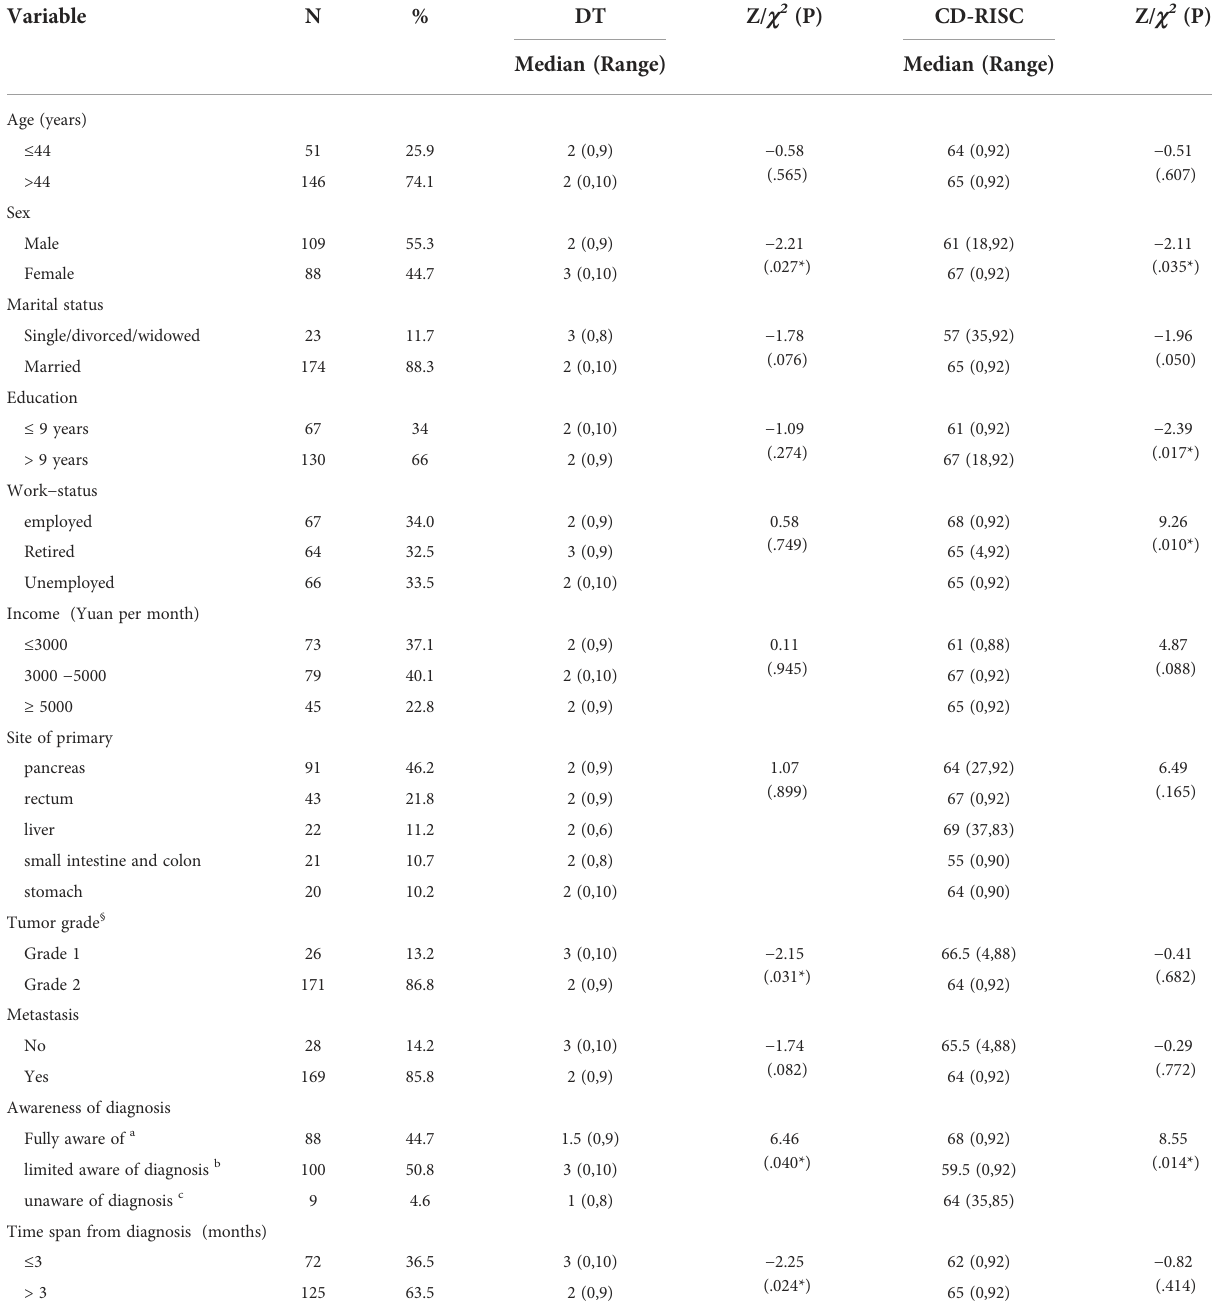
TABLE 1 Demographic and clinical characteristics of participants (N =